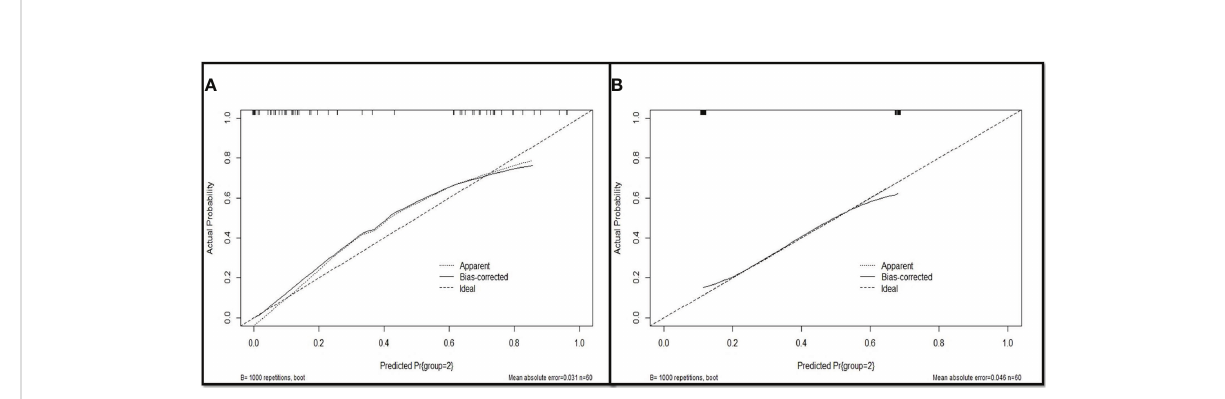
FIGURE 3 Evaluation of the nomogram for the diagnostic model for differentiating LM from LC of CRC patients. (A) The calibration curves of training cohort; (B) The calibration curves of validation